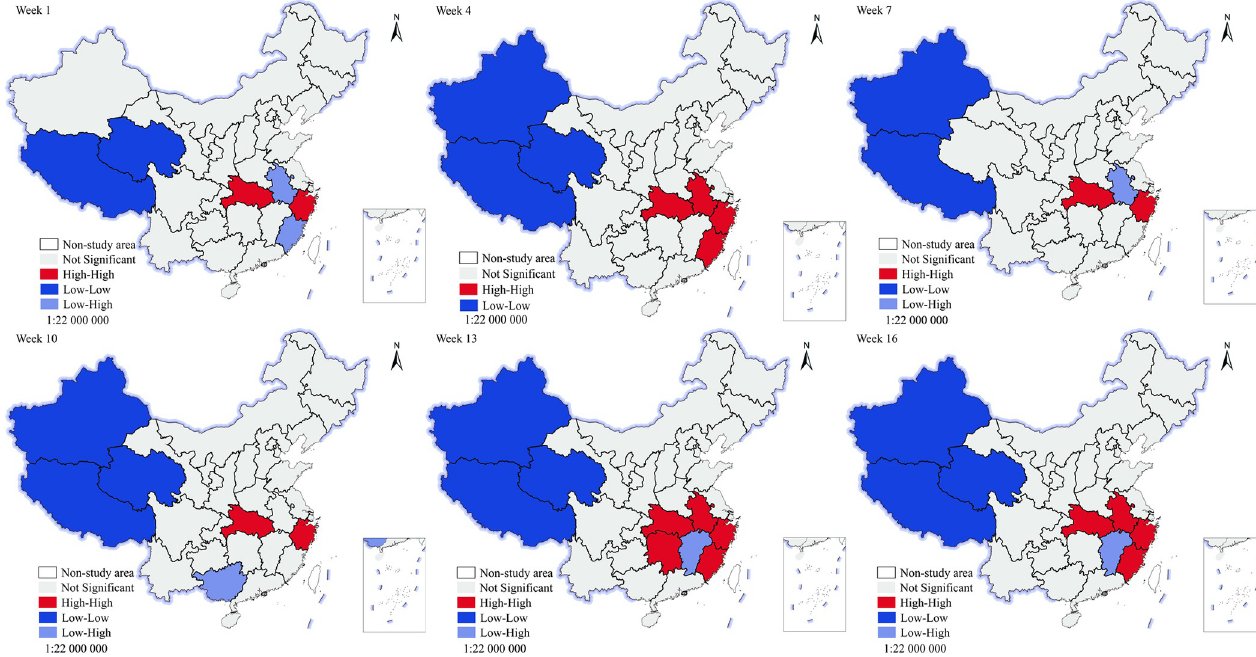
Fig 3. Lisa’s clustering chart of internet attention. The underlying layer is quoted from the Sky Map website (https://www.tianditu.gov.cn/), the standard map review number is GS (2019) 1833.